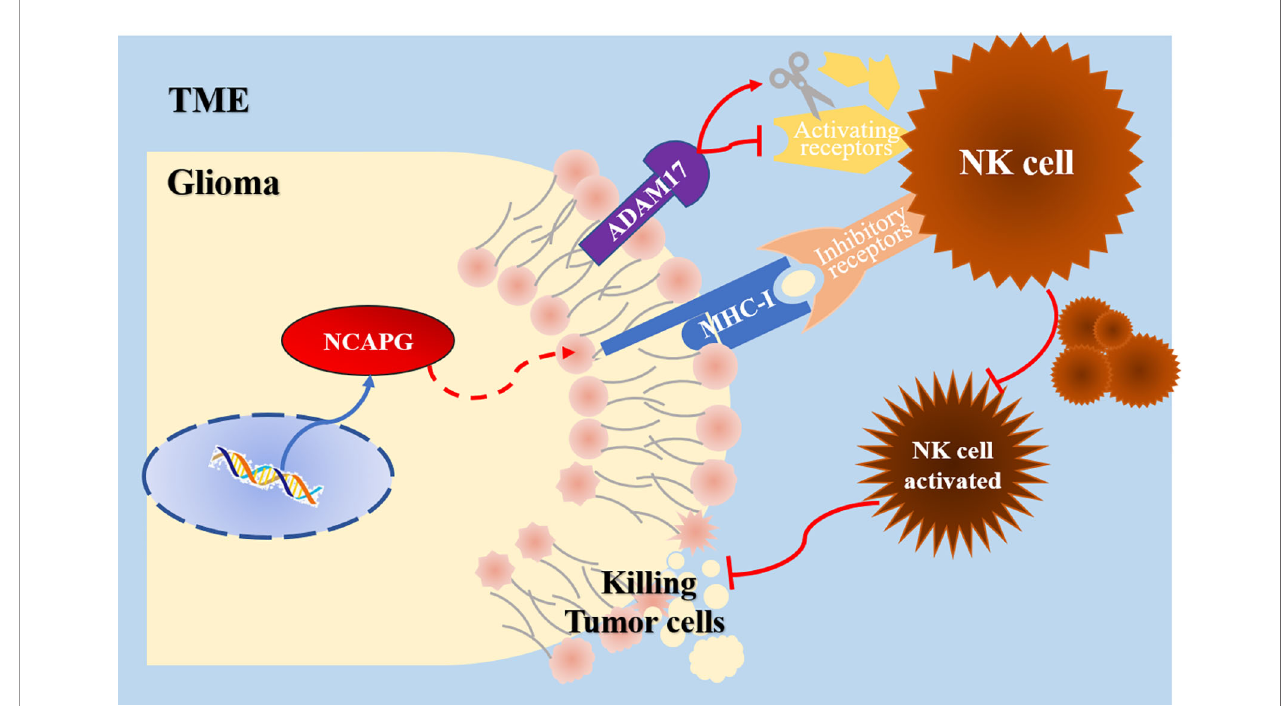
FIGURE 8 | The potential mechanism of NCAPG function in glioma TME tumor immune cell in fi